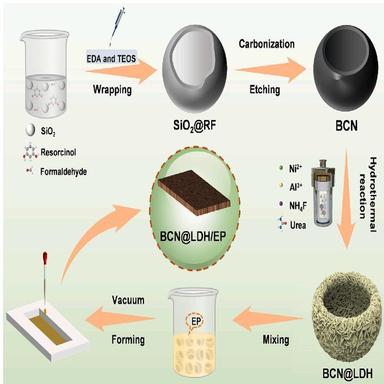
Schematic illustration for the formation of BCN@LDH/EP.